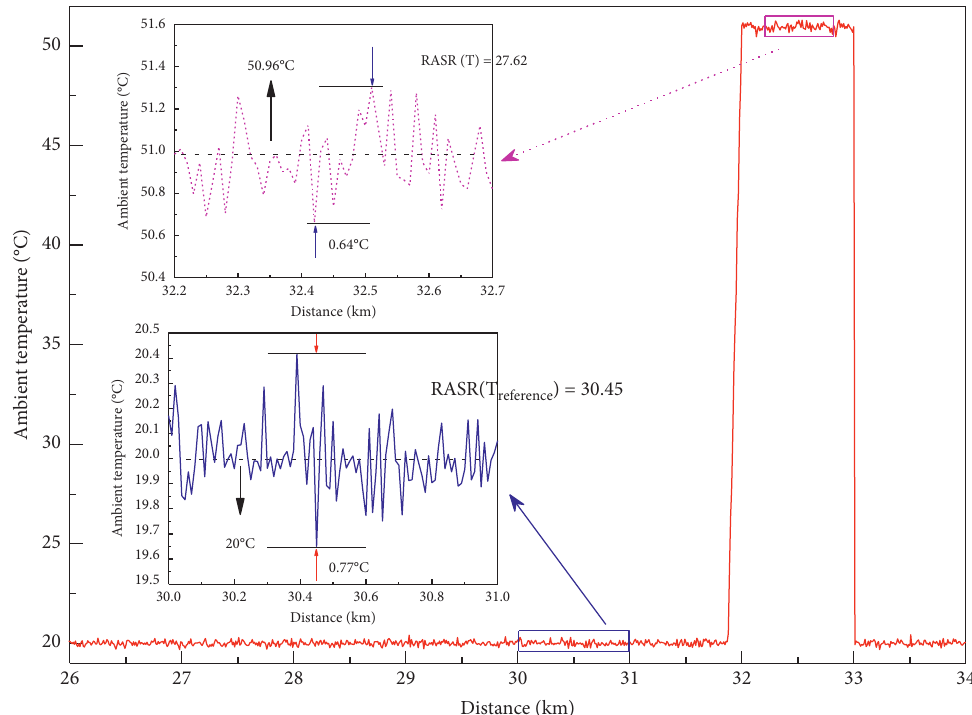
Figure 7: Measured temperature profiles along the sensing fiber.